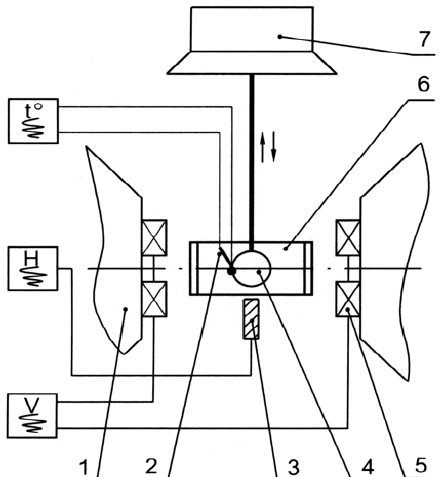
Figure 1. Scheme of a magnetometer with a vibrating sample: 1—electromagnet, 2—thermocouple, 3—Hall sensor, 4—sample, 5—measuring coils, 6—heating device, 7—electromagnetic system for excitation of periodic oscillations; t is temperature, H is intensity of magnetic field, V is heat- ing/cooling rate